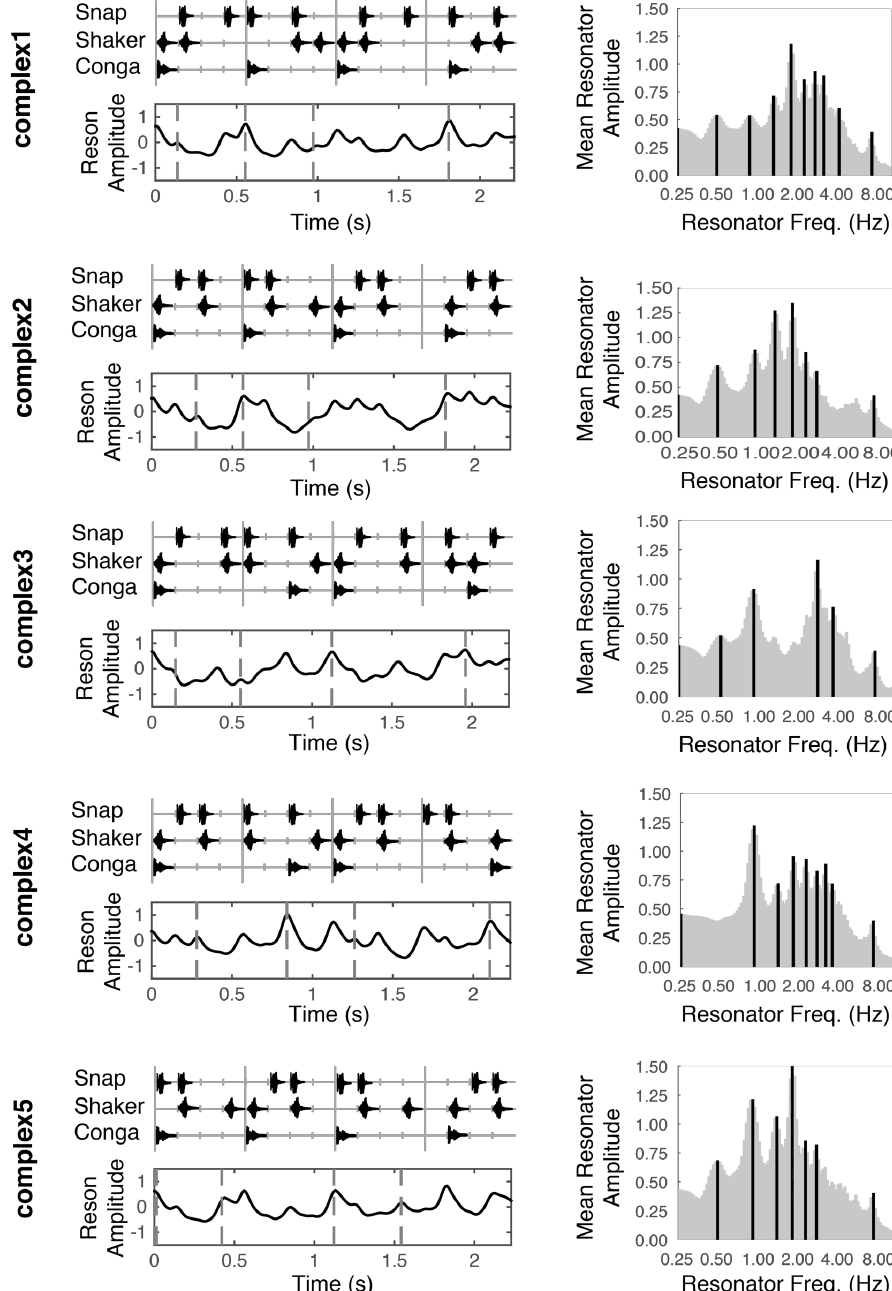
Figure 1. Stimulus patterns (left column, top panels), temporal salience predictions (left column, bottom panels), and mean periodicity profiles (right column) for each of the five stimuli used in this experiment. Vertical tick marks underly- ing the stimulus patterns (upper panels, left column) correspond to time in 140 ms intervals. Dotted vertical lines (bottom panels, left column), indicate moments in time that were probed with a deviant. These moments correspond to the musical event onset(s) directly above in the top panels. Dark vertical lines in the right column indicate peak periodicities in the mean periodicity